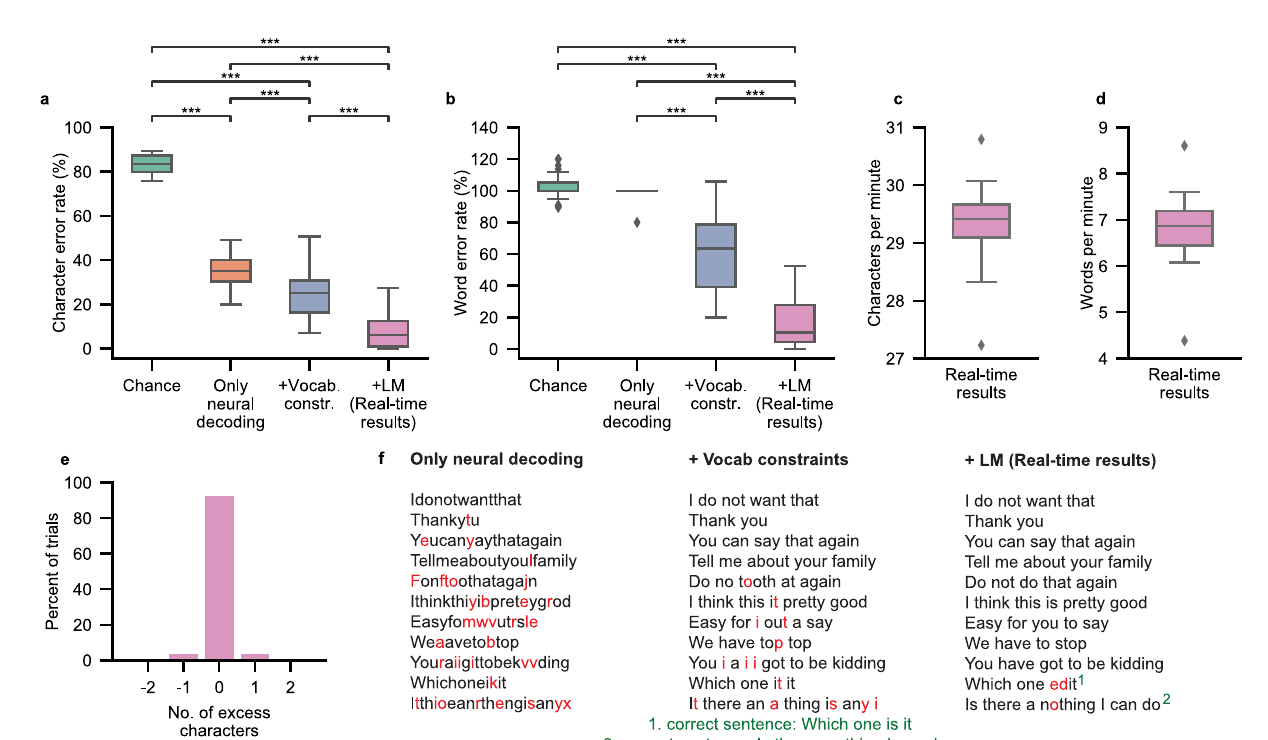
Fig. 1 | Schematic depiction of the spelling pipeline. a Atthe start of a sentence- spelling trial, the participant attempts to silently say a word to volitionally activate the speller. b Neural features (high-gamma activity and low-frequency signals) are extracted in real time from the recorded cortical data throughout the task. The features from a single electrode (electrode 0, Fig. 5a) are depicted. For visualiza- tion, the tracesweresmoothed with a Gaussian kernelwith a standard deviation of 150milliseconds.Themicrophonesignalshowsthatthereisnovocaloutputduring the task. c The speech-detection model, consisting of a recurrent neural network (RNN)andthresholdingoperations,processestheneuralfeaturestodetectasilent- speech attempt. Once an attempt is detected, the spelling procedure begins. d During the spelling procedure, the participant spells out the intended message throughoutletter-decodingcyclesthatoccurevery2.5s.Eachcycle,theparticipant is visually presented with a countdown and eventually a go cue. At the go cue, the participant attempts to silently say the code word representing the desired letter. e High-gamma activity and low-frequency signals are computed throughout the